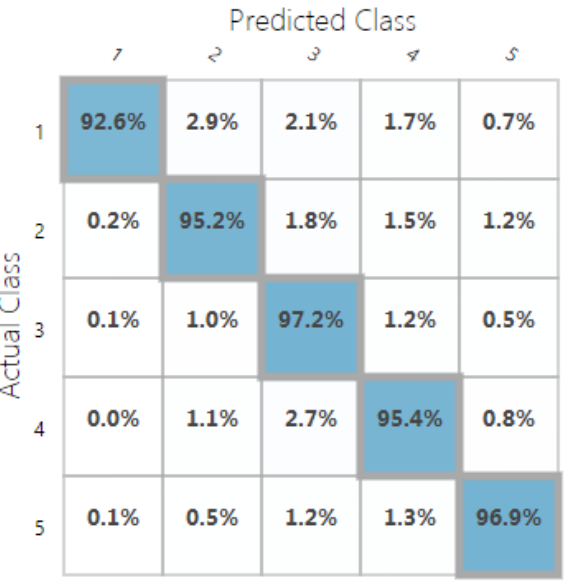
Figure 9. Confusion matrix of the trained random decision forest classification model.